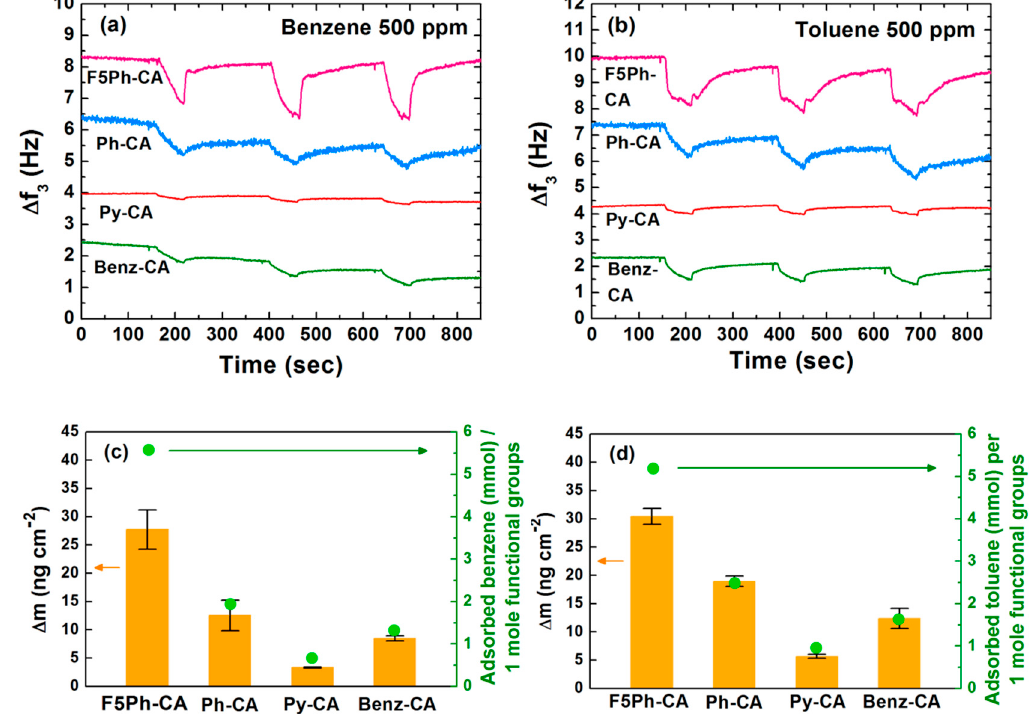
Figure 4. Frequency changes ( Δ f 3 , 3rd overtone) and mass uptake ( Δ m ) of the four functionalized cellulose acetates of F5Ph-CA, Ph-CA, Py-CA, and Benz-CA when exposed to 500 ppm of benzene and toluene vapors: ( a , b ) frequency changes upon exposure to benzene and toluene, respectively; ( c , d ) mass uptakes upon exposure to benzene and toluene, respectively.